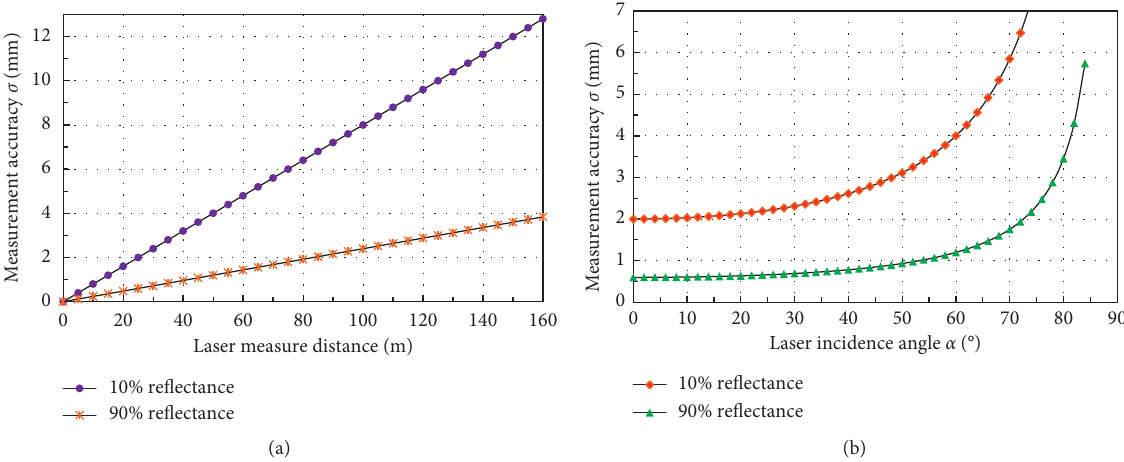
Figure 9: Variation of measurement accuracy with measurement distance and angle of incidence. (a) Measurement accuracy at different measurement distances. (b) Measurement accuracy at different laser incidence